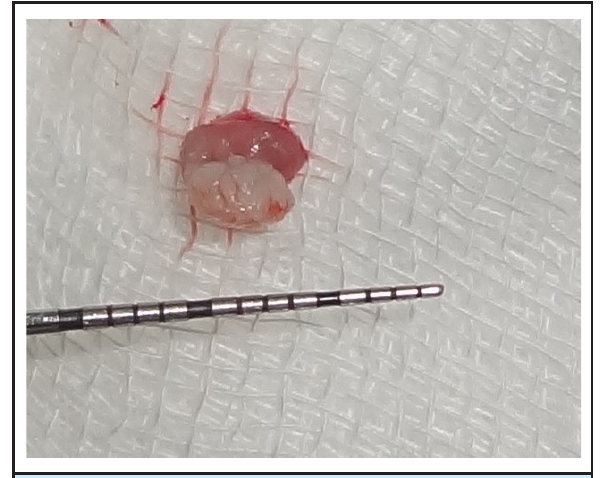
Figure 2. Soft tissue mass excised from posterior palate.